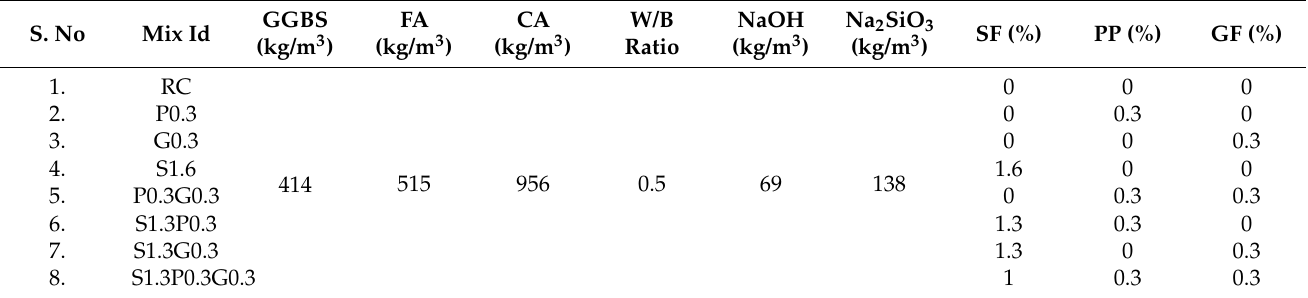
Table 2. Mix composition of geopolymer composite